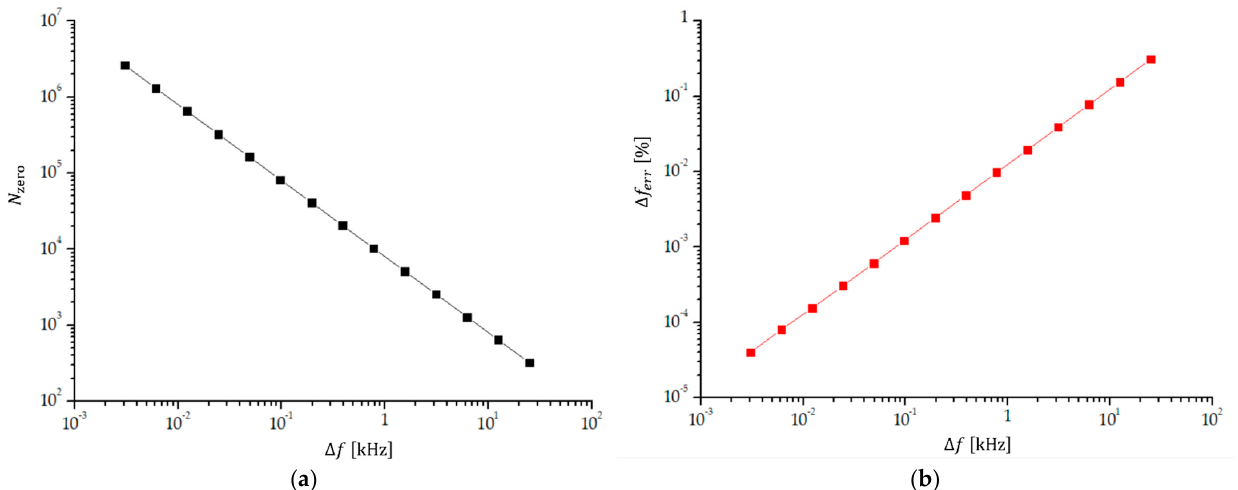
Figure 6. ( a ) The number of transitions through zero ( N zero ) ; and ( b ) relative experimental error of the measured frequency difference ( ∆ f err = 1/ N zero ) as a function of frequency difference ∆ f . The signal frequencies at ∆ f = 25 kHz are f 1 = 3.9875 MHz and f 2 = 4.0125 MHz and N zero = 320 ± 1. At ∆ f = 97.65625 Hz and f = 3.999951171875 MHz and f = 4.0000488288125 MHz, N zero = 81920 ± 1. The relative error is lower than 0.05% for the frequency differences lower than 4 kHz .